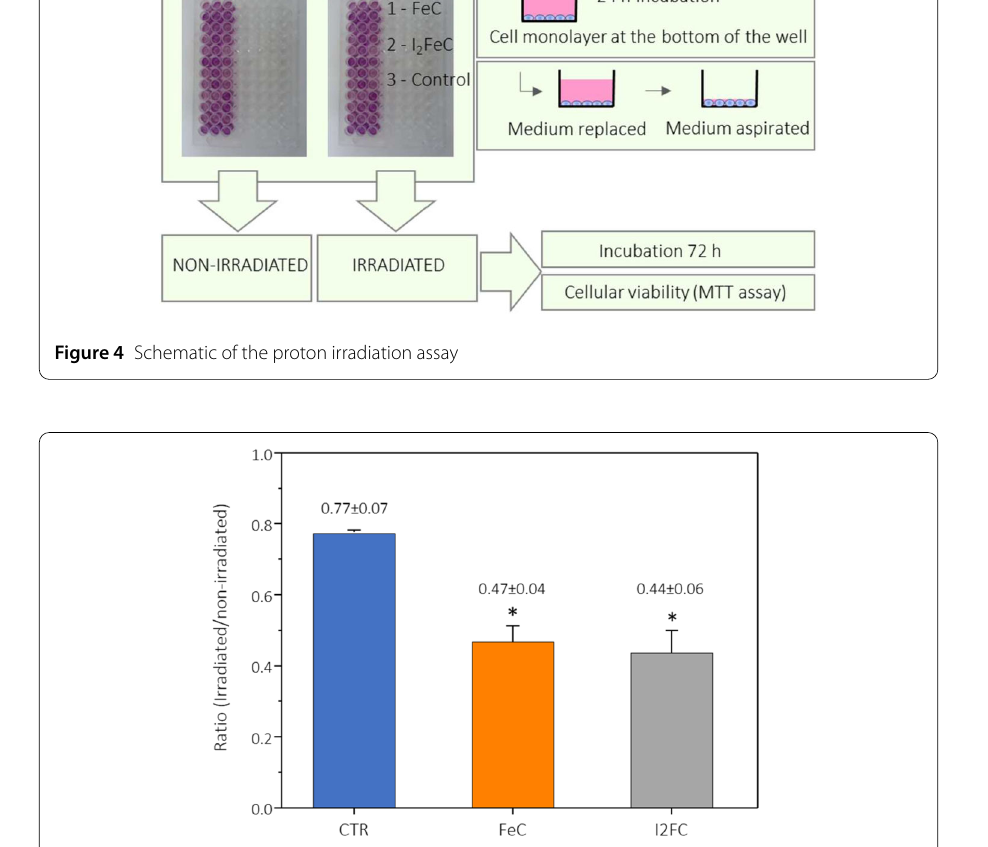
Figure 5 Viability of U87 cells after proton irradiation. Ratios between irradiated and non-irradiated cells for controls and for those cells treated with FeC and I 2 FeC compounds are plotted. Significant differences to non-irradiated cells (*) are indicated in the graph ( p <